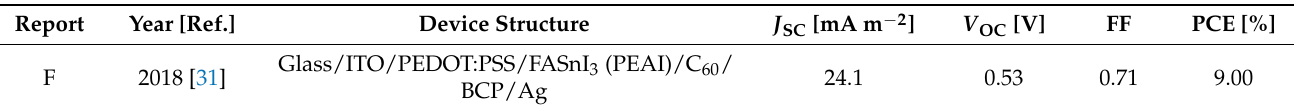
Table 3. Record table containing the reported Sn-PSCs and the corresponding photovoltaic parameters mentioned in Section 2.2.1.